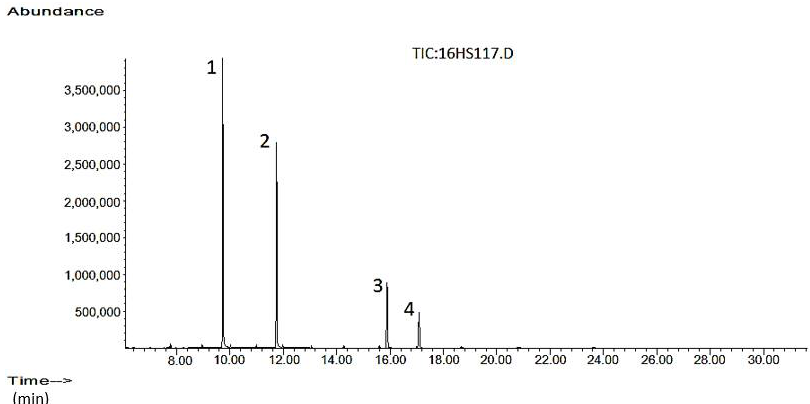
Figure 2. Retention times of endocrine disrupter chemicals (EDCs). 1: TMS-4NP, 2: TMS-BPA, 3: TMS-E 2 , 4: TMS-EE 2 .